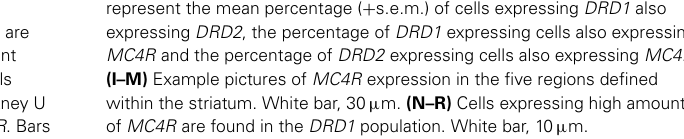
FIGURE 3 | Continued represent the mean percentage + s.e.m. of DAPI stained nuclei that are positive for DRD1, DRD2, or MC4R , where “&” indicates a significant difference of p < 0 . 05 in the mean percentage of DRD1 positive cells compared to DRD2 positive cells (as determined by the Mann–Whitney U test). (H) Quantification of coexpression of DRD1 , DRD2, and MC4R . Bars